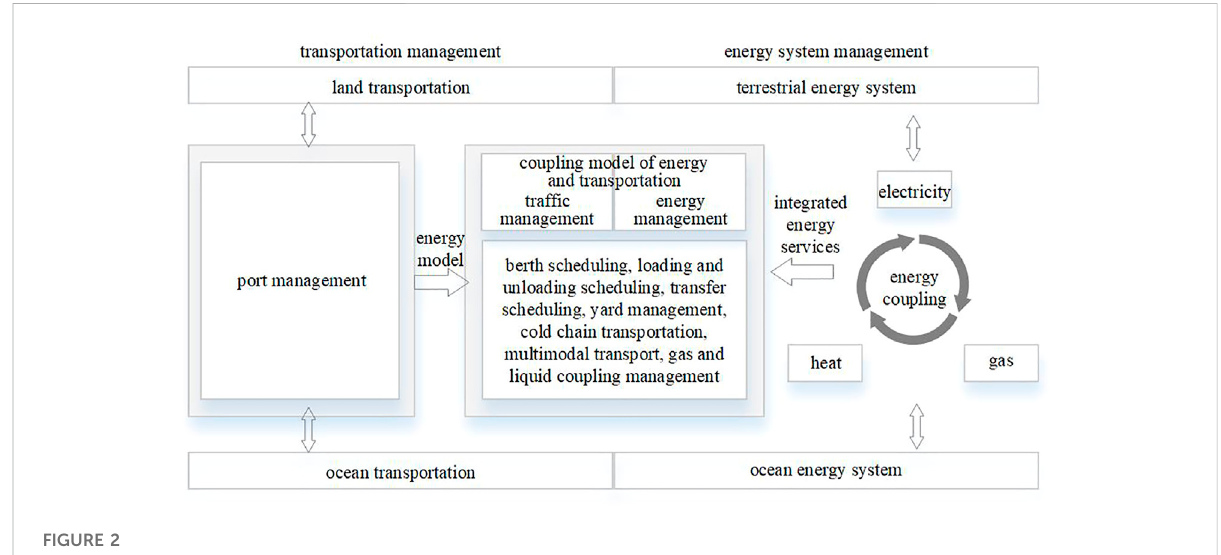
FIGURE 2 Coupling relationship between energy and transportation.